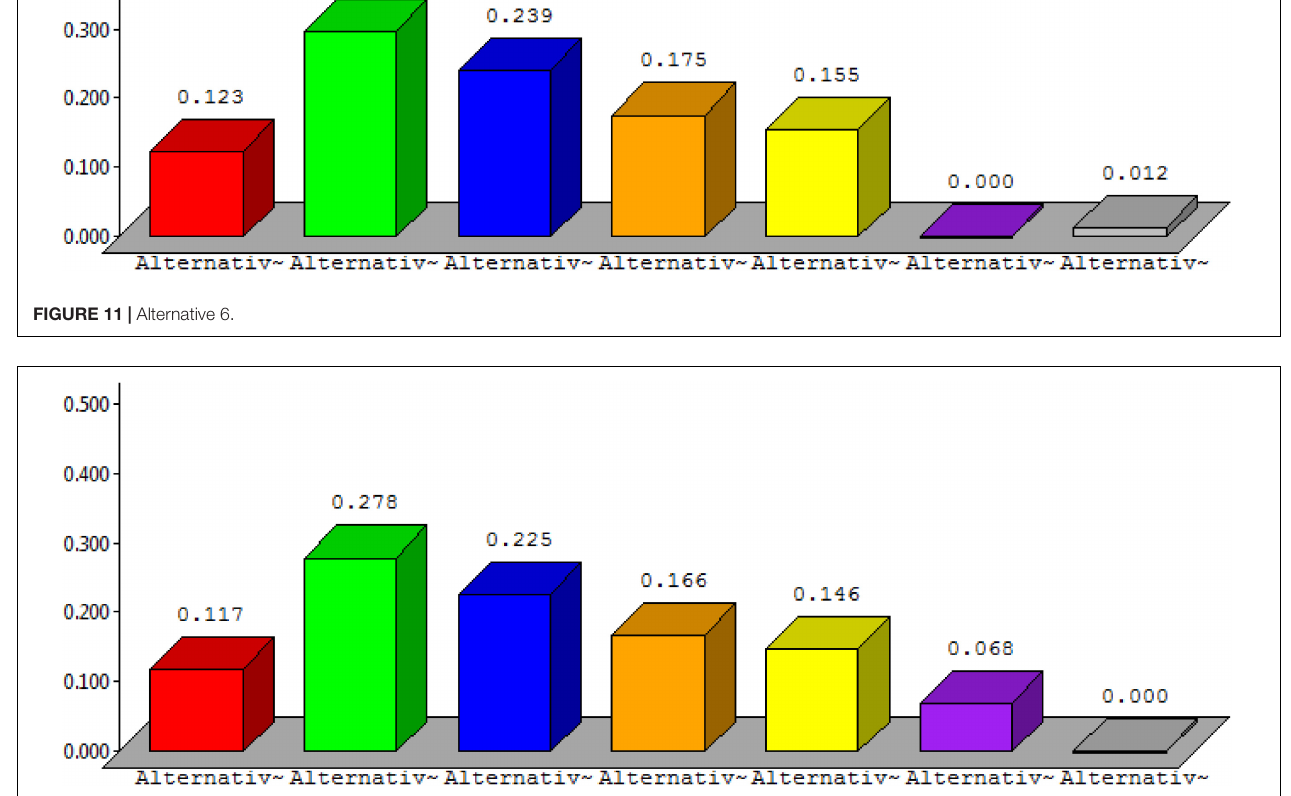
FIGURE 12 | Alternative 7.